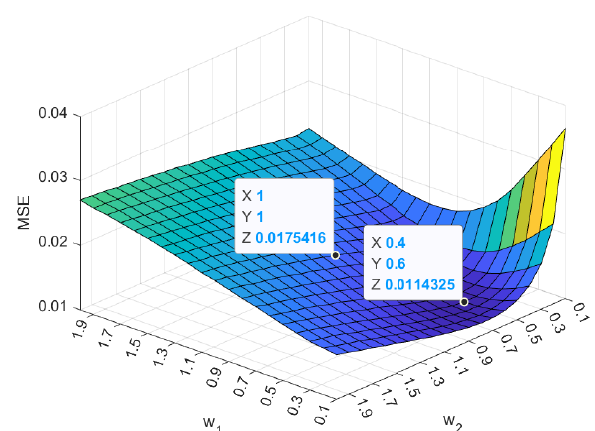
Figure 2. The MSE performance of the proposed F-SBL algorithm according to different values of weights w 1 and w 2 for SNR = 12